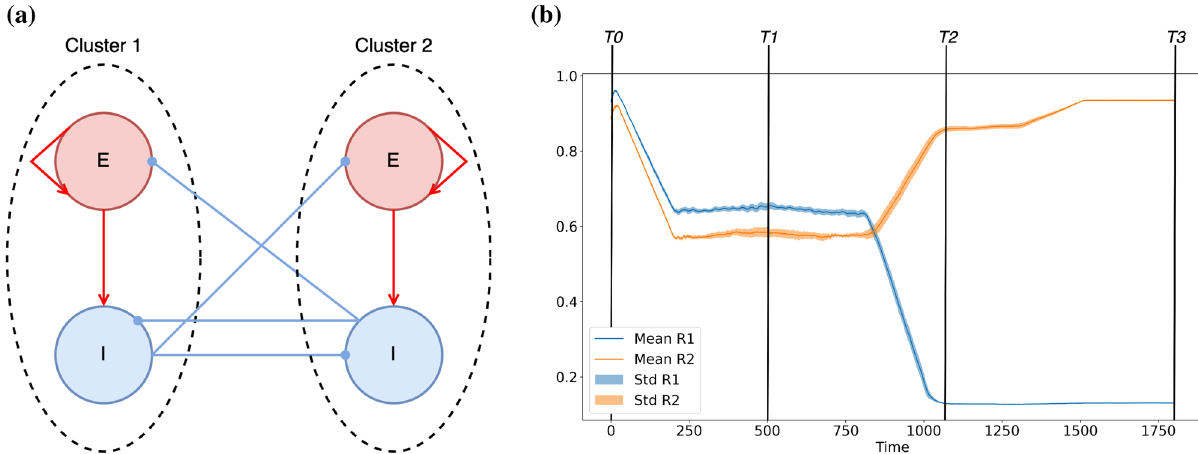
Figure 4. ( a ) Schematic diagram representing the connectivity matrix emerging after the consolidation phase for the stimulation of two non overlapping populations reported in Fig. 3. Red (blue) circles represent excitatory (inhibitory) populations, dashed circles identify clusters of synchronized neurons. ( b ) Evolution of the modulus of the 1st (in blue) and 2nd (in orange) Kuramoto–Daido order parameters, Eq. (2), averaged over 10 realizations with randomised initial conditions and stimulation sequences. The mean and the corresponding standard deviation are shown versus time during the realization of the experiment in Fig. 3. The time labels have the same meaning as in Fig.